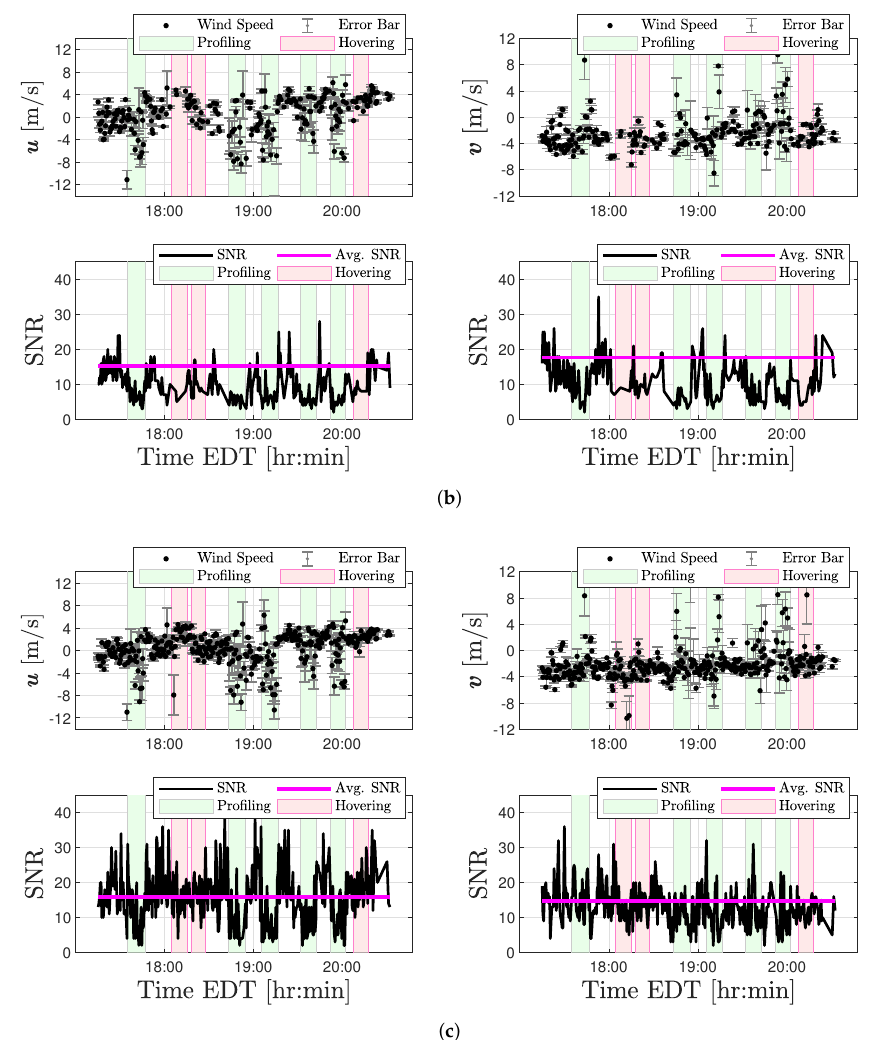
Figure A3. Singal-to-noise ratios for u and v wind velocity observations from the LR-SoDAR at